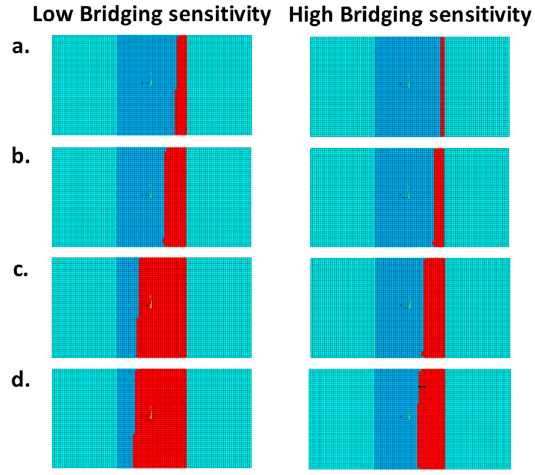
Figure 14. Delaminated area at: ( a ) 2.5 mm applied displacement, ( b ) 3.6 mm applied displacement, ( c ) 5.6 mm applied displacement, ( d ) 6.8 mm applied displacement. Low and high bridging sensitivity.